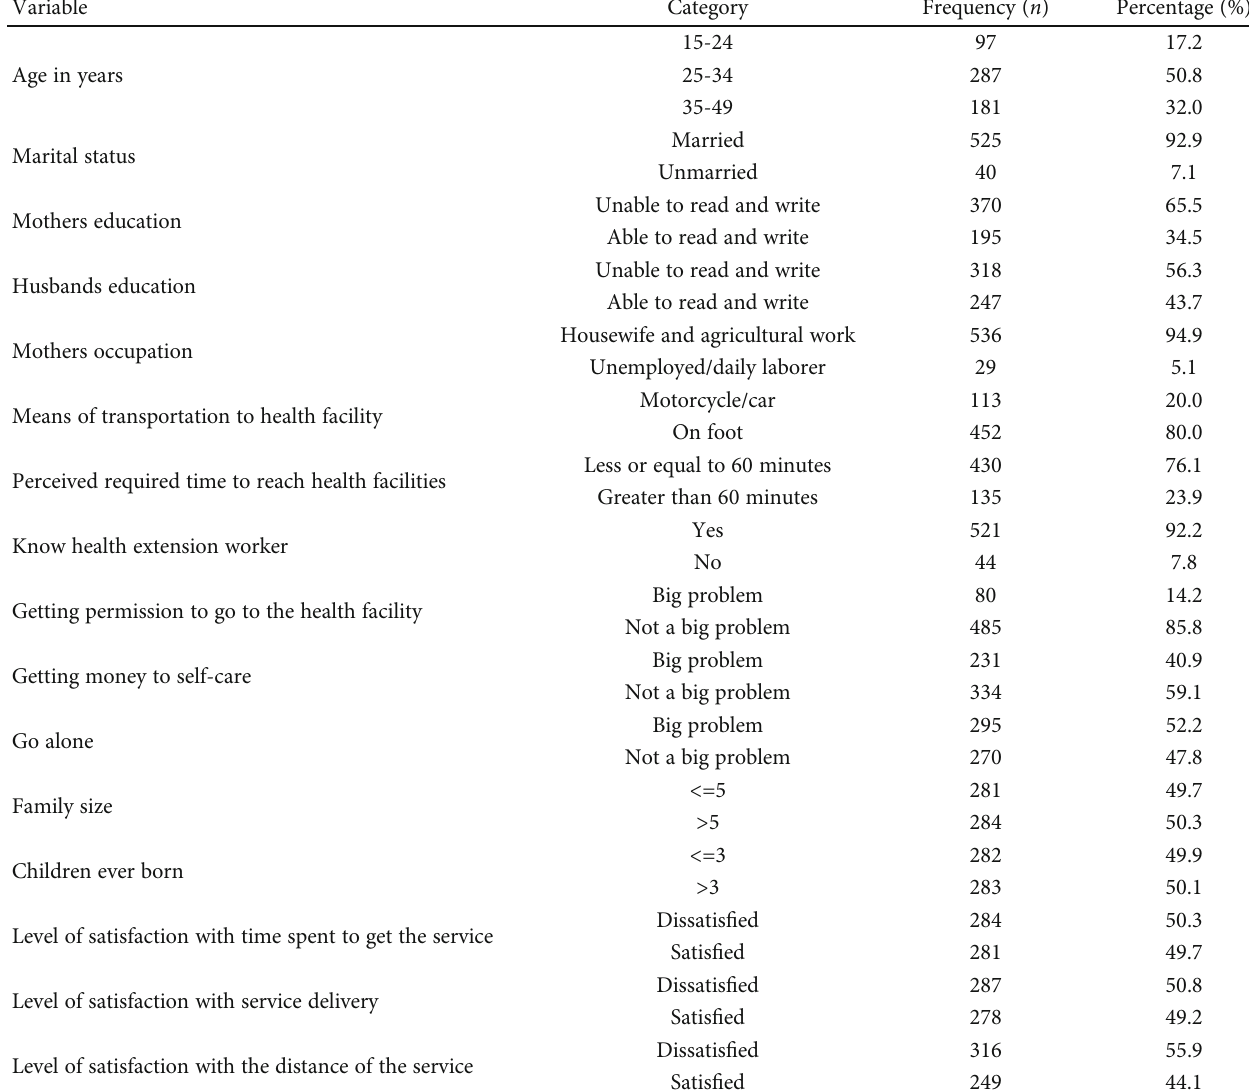
Table 1: Sociodemographic characteristics of study participants ’ fi ndings from the primary health care project in two northwest Ethiopian districts, September 2019 ( n = 565